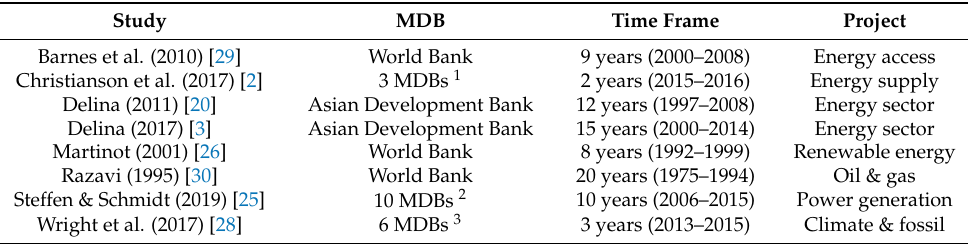
Table 1. Overview of literature on energy financing of